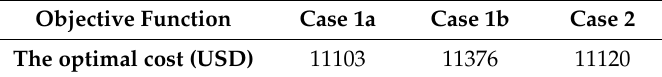
Figure 10. RoCoF and frequency nadir for Case 1b. Table 3. Comparison of optimal costs between Cases 1 and 2.